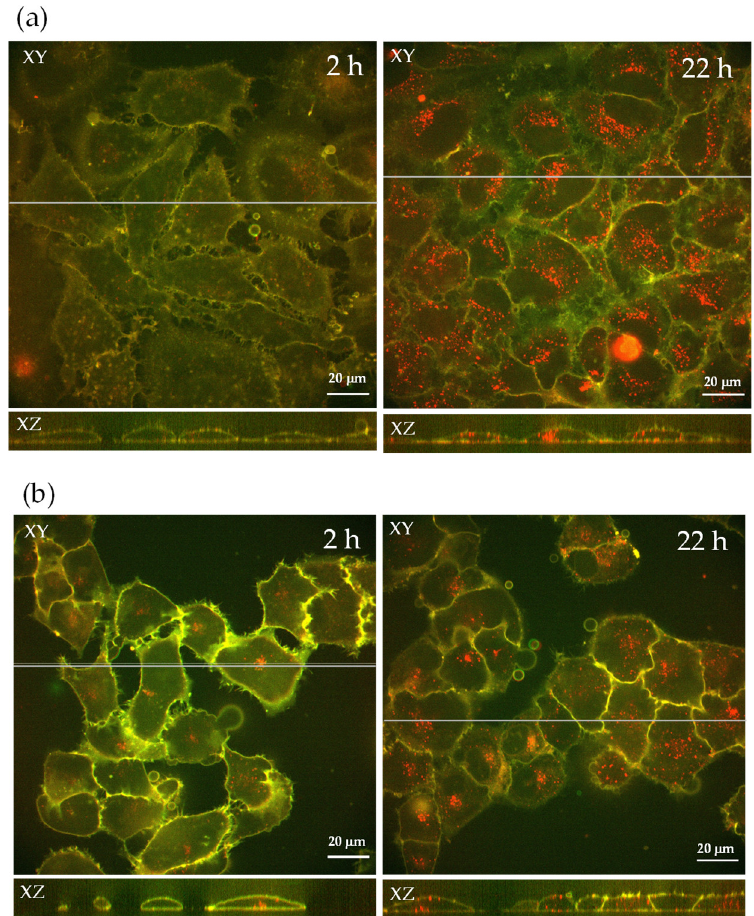
Figure 8. Confocal images of fluorescent H9 nanogel (red) accumulation in HeLa ( a ), and PANC1 cells ( b ), after incubation for 2 and 22 h. Plasma membranes are shown in yellow. The bottom images are cross-sectional images taken at the lines in the top images.